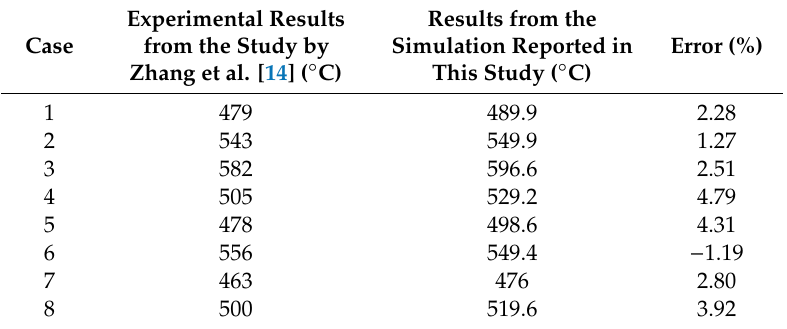
Figure 4. Comparison of the measured and calculated air outlet temperatures under different conditions (simulation and reported devices had identical operating and geometric conditions). Table 5. The measured and simulated data and their deviations.